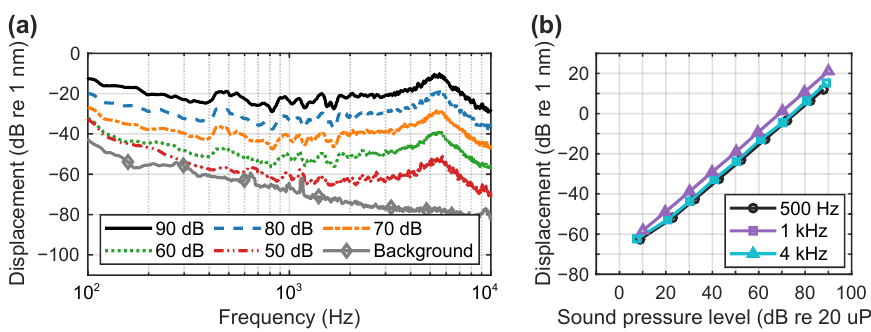
Figure 7. Membrane displacement measurements with different SPLs from ( a ) an overall value of 90 dB to 50 dB and the background noise of the LDV, and ( b ) 90 dB to 10 dB measured by a reference microphone at 500 Hz, 1 kHz and 4